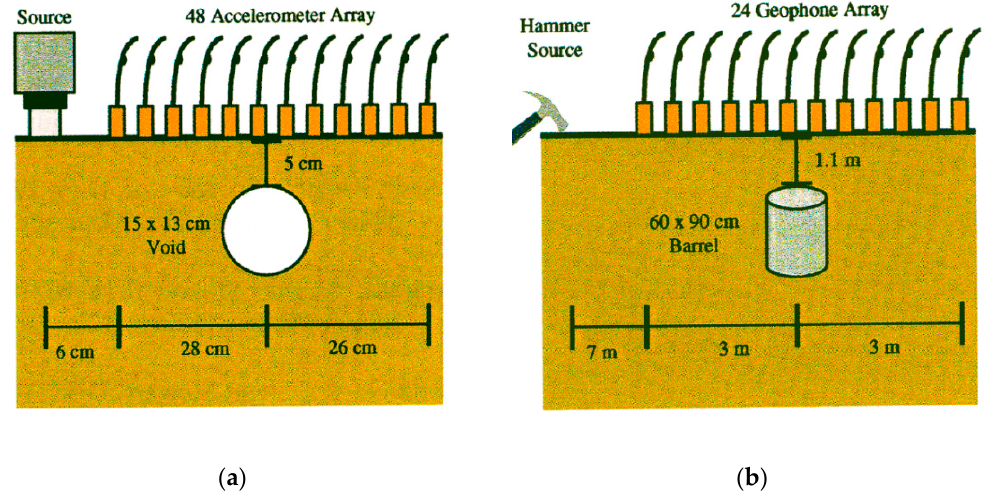
Figure 17. Experimental set-ups of surface wave method in present of ( a ) a void; ( b ) a metal barrel [112].